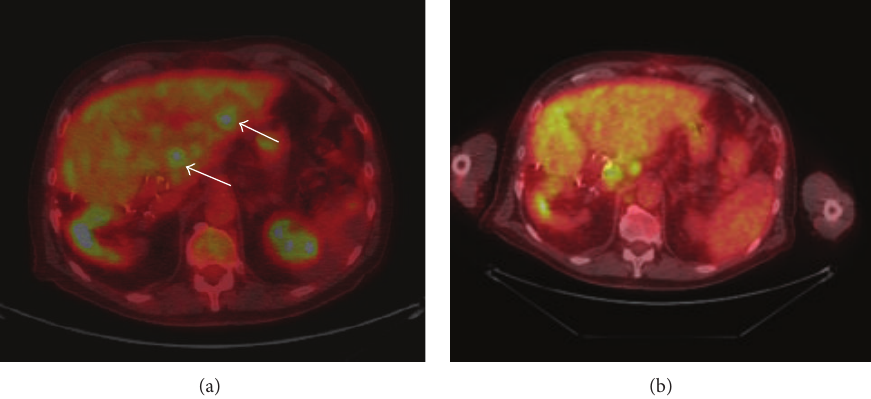
Figure3:AxialPET-CTimages(a)beforebiliarydrainageandSIRTand(b)twomonthsafterSIRT,atthelevelofsegments2and3.Significant response to treatment is evident, with resolution of FDG avid hepatic metastases (arrows). However, progression of extrahepatic disease was noted in portocaval and periaortic